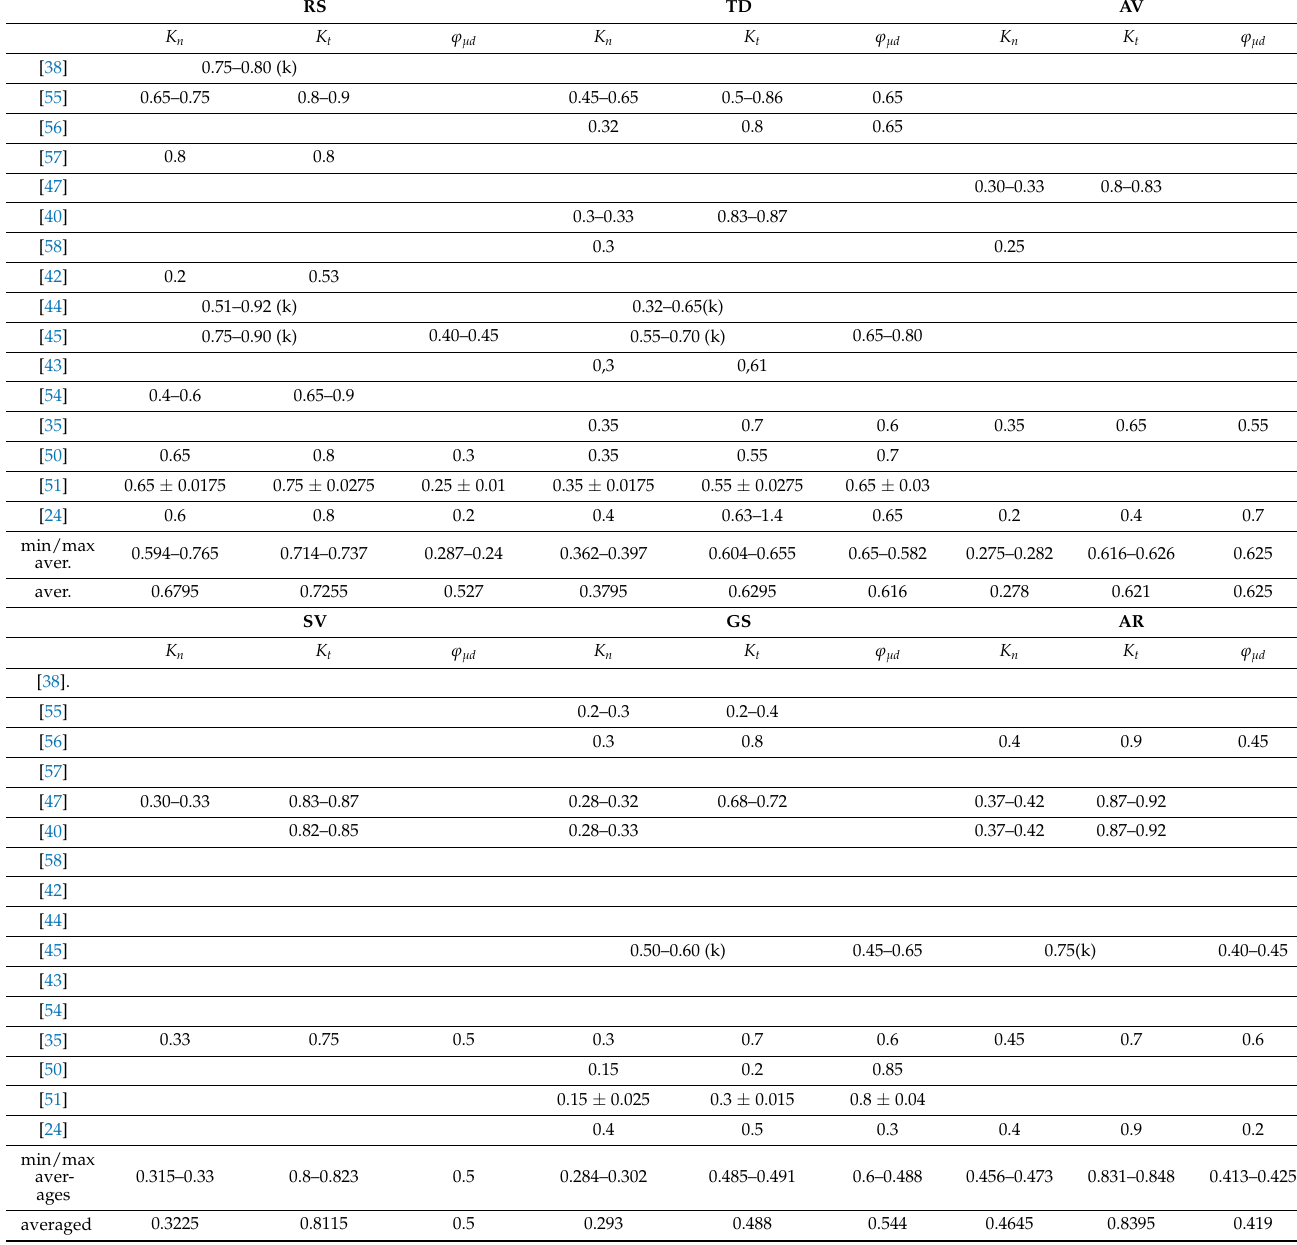
Table 1. Literature review of kinematic parameters values for slope terrain classes recognized in the study area. Legend: RS = Rock slope; TD = Talus Deposits; AV = Arboreal Vegetation; SV = Shrub-like Vegetation; GS = Grass-covered Soil; AR = Asphalt